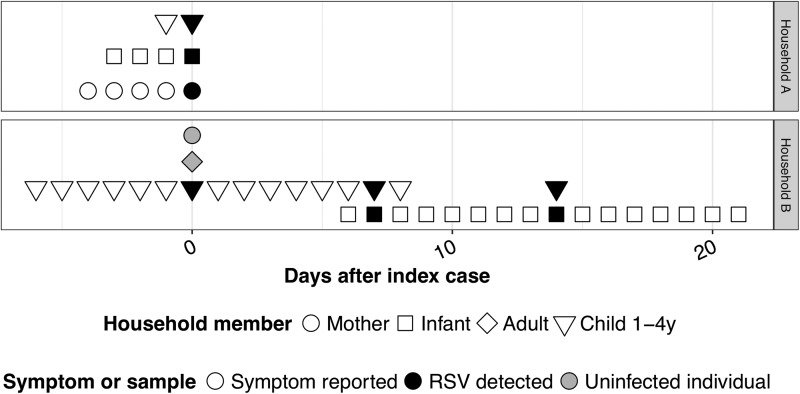
Examples of symptoms and RSV-positive specimen collection in two examples of RSV infection clusters in two households (a and b). Each row represents an individual, each unfilled symbol represents 1 day of symptoms, black filled symbols represent positive specimen collection and varying symbols represent household member type. Index cases are those whose symptoms first appear before the initial RSV-positive specimen.